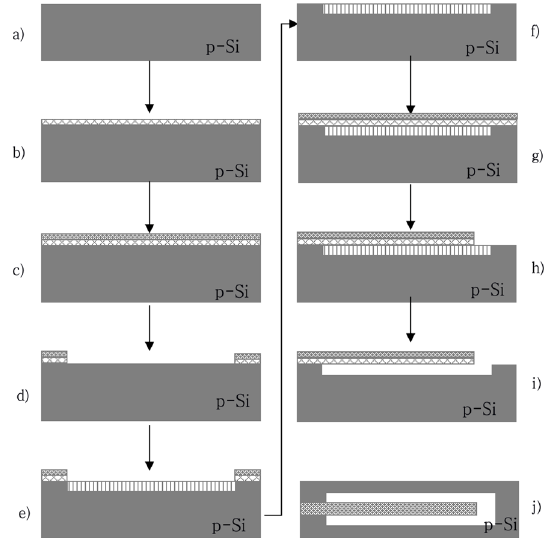
Figure 2. Schematic diagram of the cantilever beam process. ( a ) Cleaning the substrate. The standard general cleaning in the MEMS process is used to clean the surface of the substrate. ( b ) Manufacture of SiO 2 film using thermal oxidation technology. It is used for the patterned mask layer of porous silicon, the thickness is 120 nm. ( c ) Growing Si 3 N 4 by LPCVD(Low Pressure Chemical Vapor Deposition). It is used for the patterned mask layer of porous silicon, the thickness is 180 nm. ( d ) Photoetch the porous silicon preparation area to protect the front side and remove the dielectric layer on the back side. Make the substrate have certain conductivity and improve the uniformity of porous silicon preparation. ( e ) Electrochemical preparation of porous silicon [20–22]. The mixed solution of 15% HF and absolute ethanol is used as the electrolyte. The current density is set to 50 mA/cm 2 , the film formed on the surface of the porous silicon layer is smooth and flat, and the porosity of the prepared sacrificial layer is controllable. And when the cantilever is released, the removal rate is moderate, which can effectively reduce the probability of damage to the cantilever. Molybdenum is used as a double-slot electrochemical corrosion electrode, the distance between the electrode and the silicon wafer is fixed, and the electrification time is 30 min. The thickness of porous silicon can reach 20 μ m. ( f ) Removing the SiO 2 /Si 3 N 4 . After electrochemical etching, the SiO 2 /Si 3 N 4 film on the surface is removed, and the substrate is cleaned at the same time, in preparation for the subsequent growth of the multi-layer heterogeneous cantilever beam film. ( g ) Multi-layer heterogeneous film is composed of SiO 2 /SiN x , metal electrodes and piezoelectric sensitive film between metal layers. Use PECVD (Plasma Enhanced Chemical Vapor Deposition) to make SiO 2 /SiN x film, and magnetron sputtering to make metal film and sensitive film. The schematic diagram is shown in Figure 2g. ( h ) Use photolithography, wet etching and RIE (reactive ion etching) technology to fabricate cantilever structures. ( i ) Use wet etching technology to remove porous silicon to achieve cantilever beam release. Using a KOH solution with a concentration of 0.5% can effectively remove porous silicon without causing damage to the cantilever film. Au is used as the metal electrode material. Put the substrate in the KOH solution and take it out after 30 min. ( j ) The top view of the cantilever beam structure.